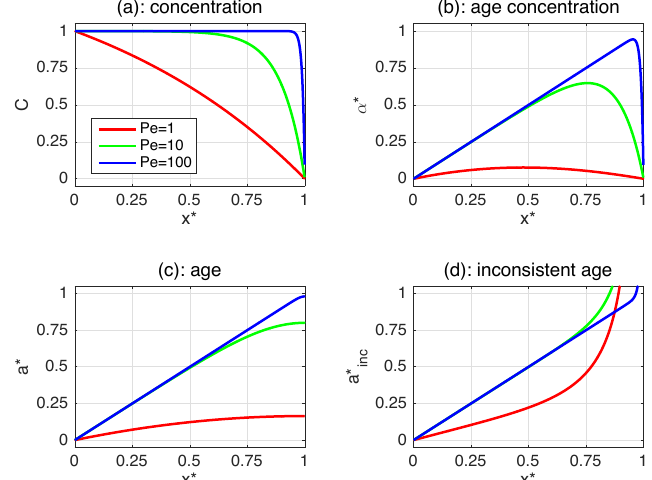
Figure 5. Illustration of ( a ) concentration (45), ( b ) age concentration (46), and ( c ) the associated age. Panel ( d ) depicts the inconsistent age that is obtained as the ratio of inconsistent age concentration (49) and correct concentration (49). Dimensionless variables are represented. They are identified by asterisks and are x ∗ = x / L , α ∗ = U α / L , a ∗ = Ua / L and a ∗